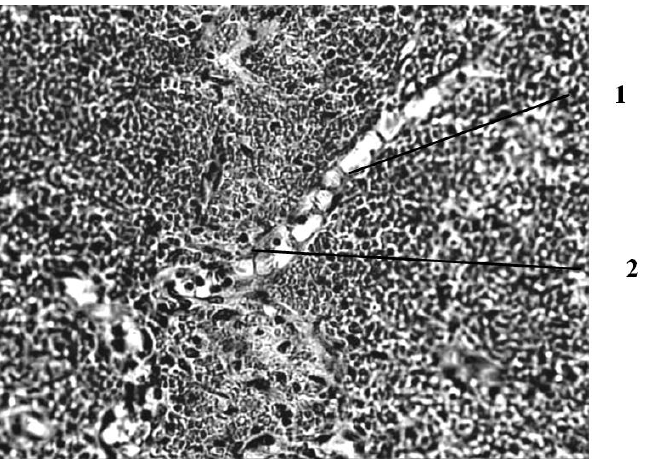
Figure 4. Intensive proliferation of connective tissue cells in the adipose tissue surrounding the skin’s own muscle, the formation of new capillary-type vessels in rats treated with ozone–oxygen mixture (1 — clusters of red blood cells, 2 — newly formed microvessels). magn. ×400.